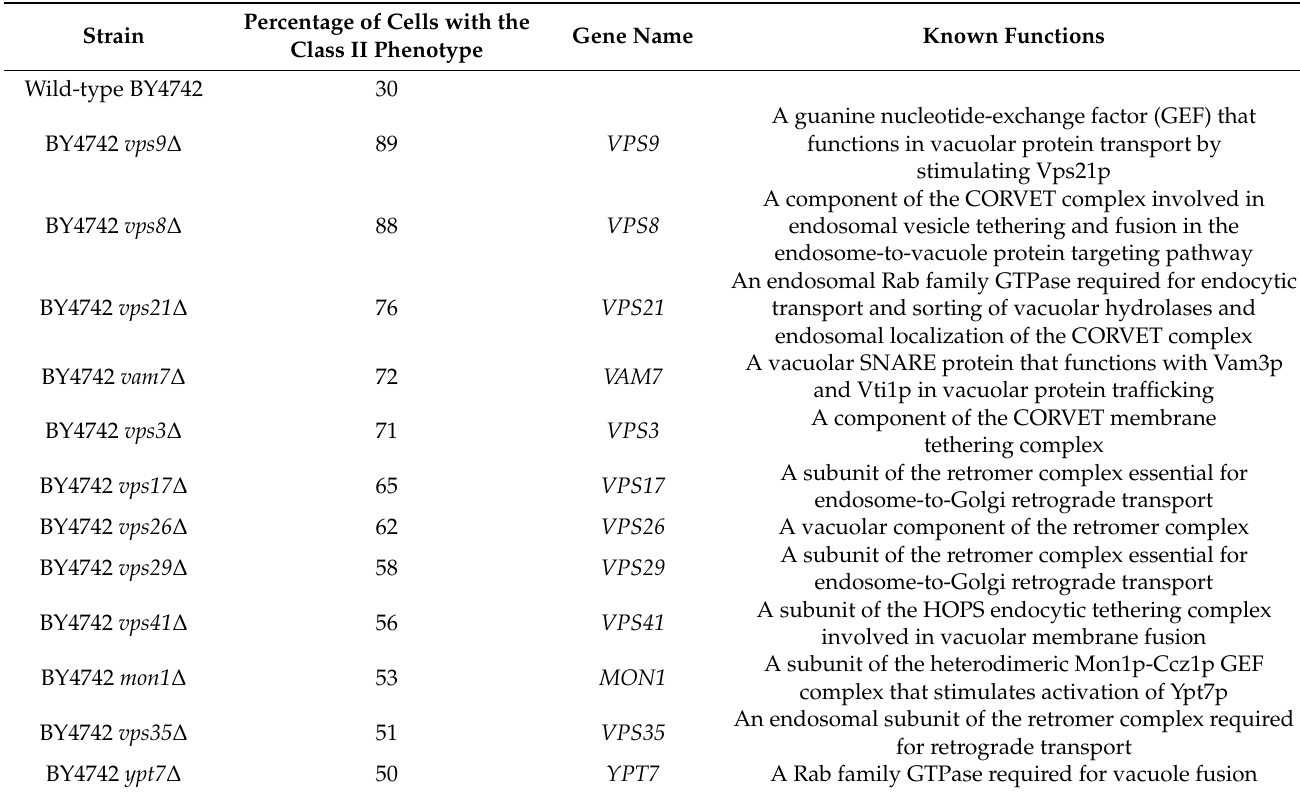
Figure 1. Schematic representation of the genome-wide screen identifying genes that regulate Pma1p asymmetry during cell division. Yeast cells from a collection of single-gene deletion mutants (EUROSCARF, Scientific Research and Development GmbH, Germany) were transformed with a plasmid DNA encoding Pma1p-EGFP, and GFP fluorescence along the plasma membrane of mother and daughter cells were analyzed by fluorescence microscopy. Table 1. List of deletion strains isolated from a genome-wide screen in which the asymmetric distribution of Pma1p-EGFP during cell division was disrupted. Strain